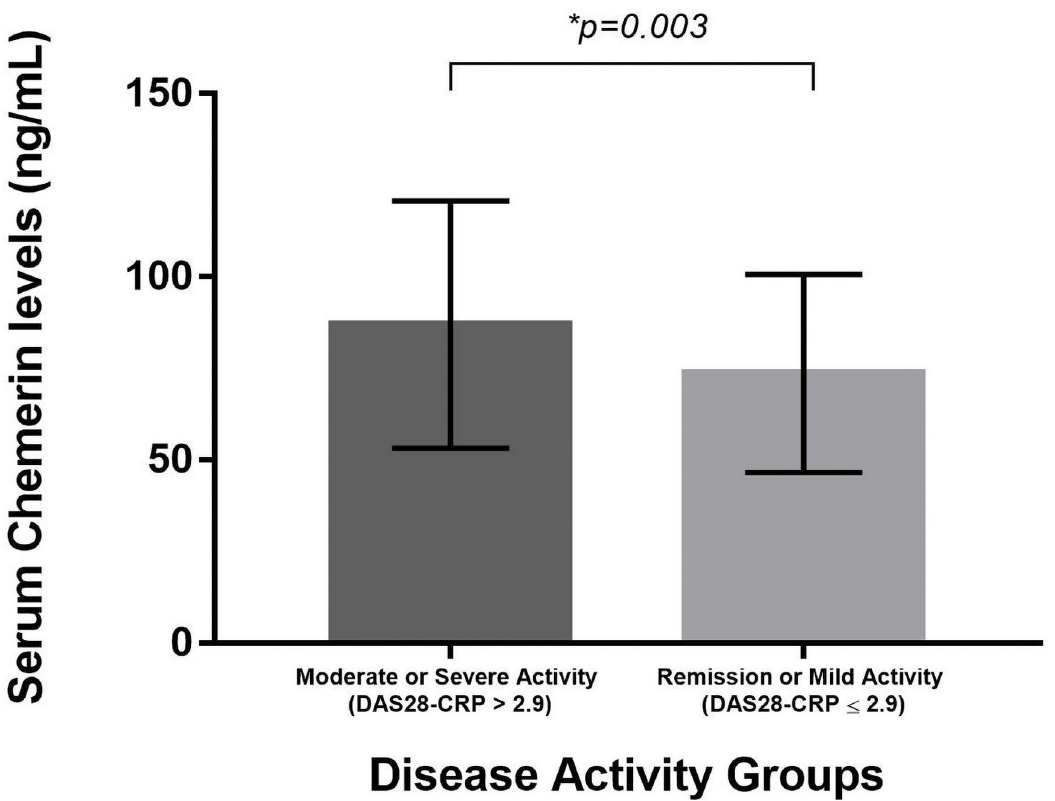
Fig 2. Comparison of serum chemerin levels between RA with moderate/severe disease activity versus RA in remission/mild activity.